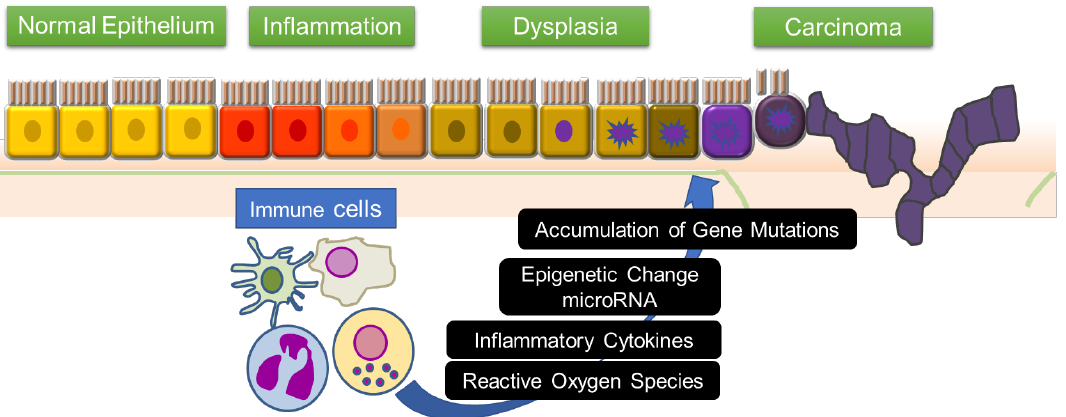
Figure 1. “Inflammation–dysplasia–carcinoma” sequence and immune system. In the intestinal mucosa of IBD patients, inflammation-triggering mutations and abnormalities of genes accumulate, leading to colorectal cancer via dysplasia. In this process, inflammatory cytokines and reactive oxygen species induce epigenetic changes and changes in microRNA expression in pre-malignant cells. This leads to mutations in tumor related genes, which results in the initiation of colitis-associated cancer.